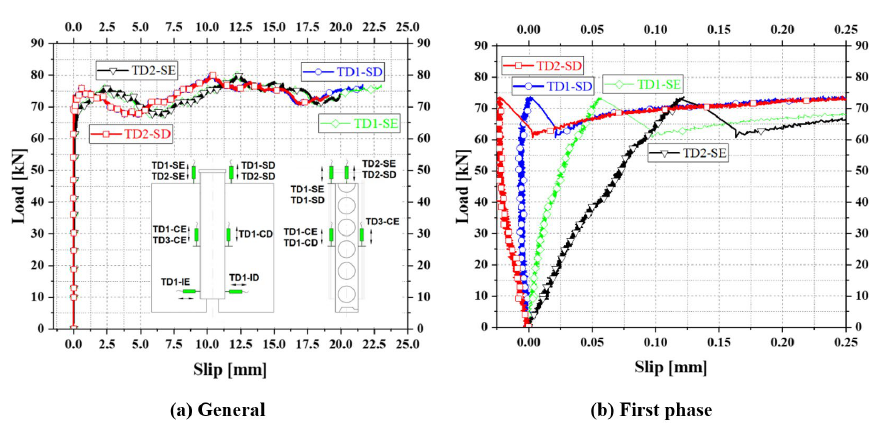
Fig. 8: Load versus slip curves at the top of